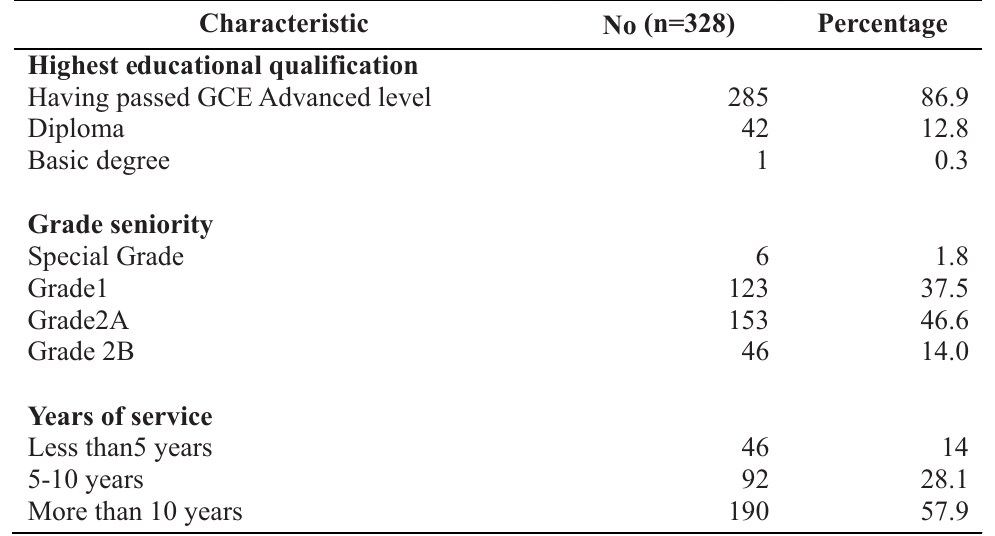
Table 1: Distribution of educational qualifications, grade seniority and experience of the nursing officers Characteristic